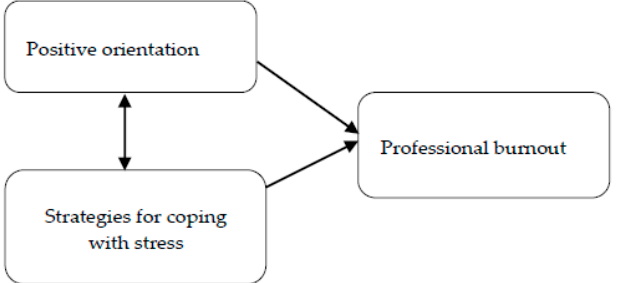
Figure 1. Model of the relationship between professional burnout, strategies for coping with stress, and a positive orientation .